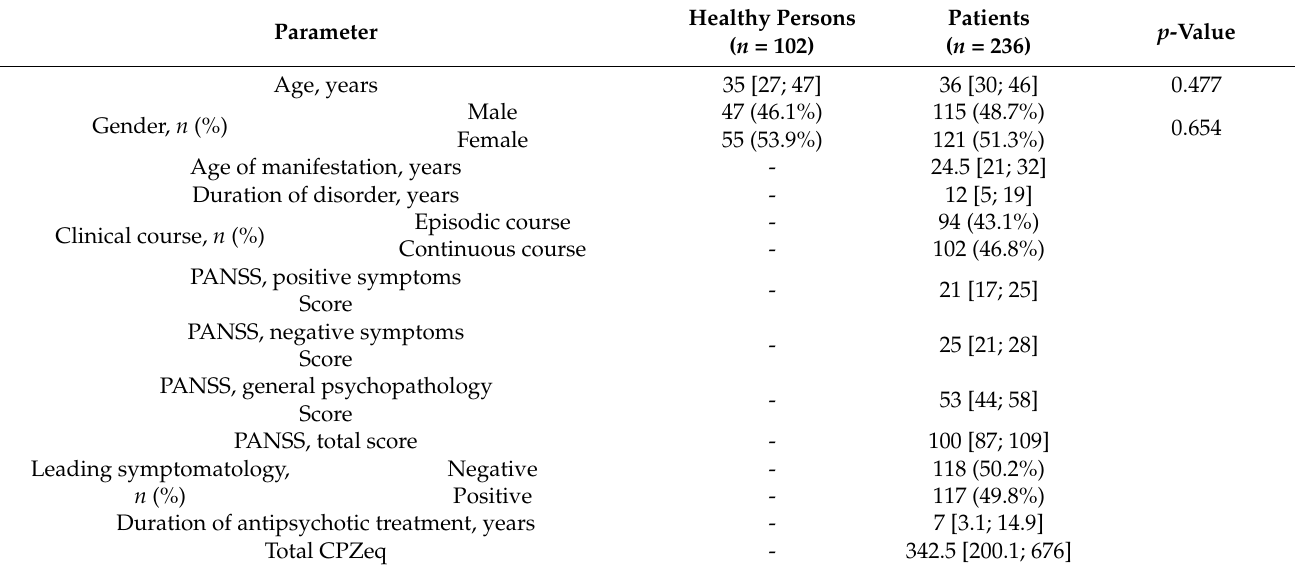
Table 1. Basic demographic and clinical characteristics of